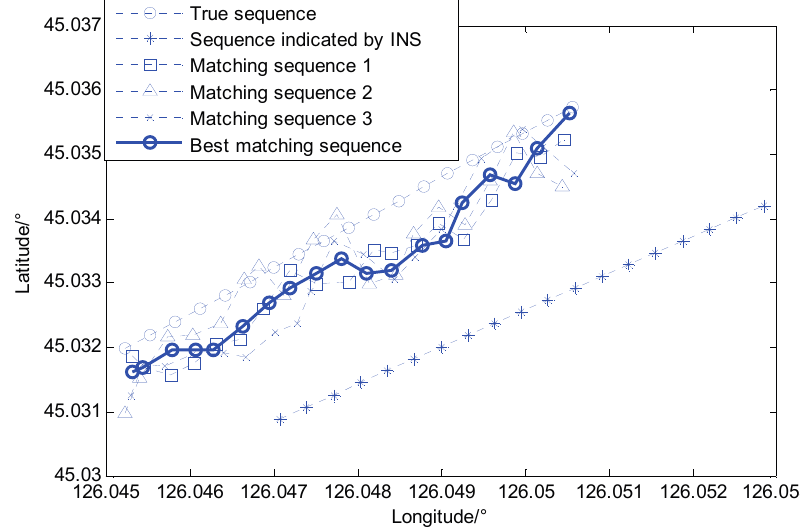
Figure 14. Screening for best matching result by Hausdorff distance.